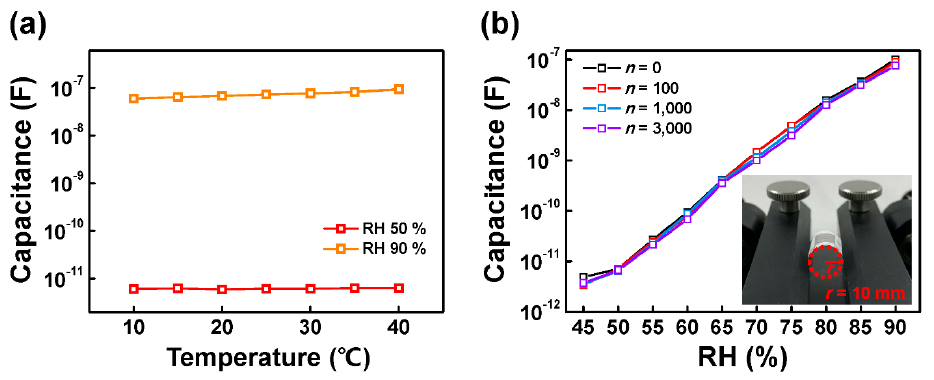
Figure 4. ( a ) Temperature-dependent characteristics of H-PTFE sensor with RH of 50% and 90%; ( b ) sensing behaviors of H-PTFE flexible humidity sensor under cyclic bending stress ( r = 10 mm) with bending cycles of n = 0, 100, 1000, and 3000. Inset: image of cyclic bending test.